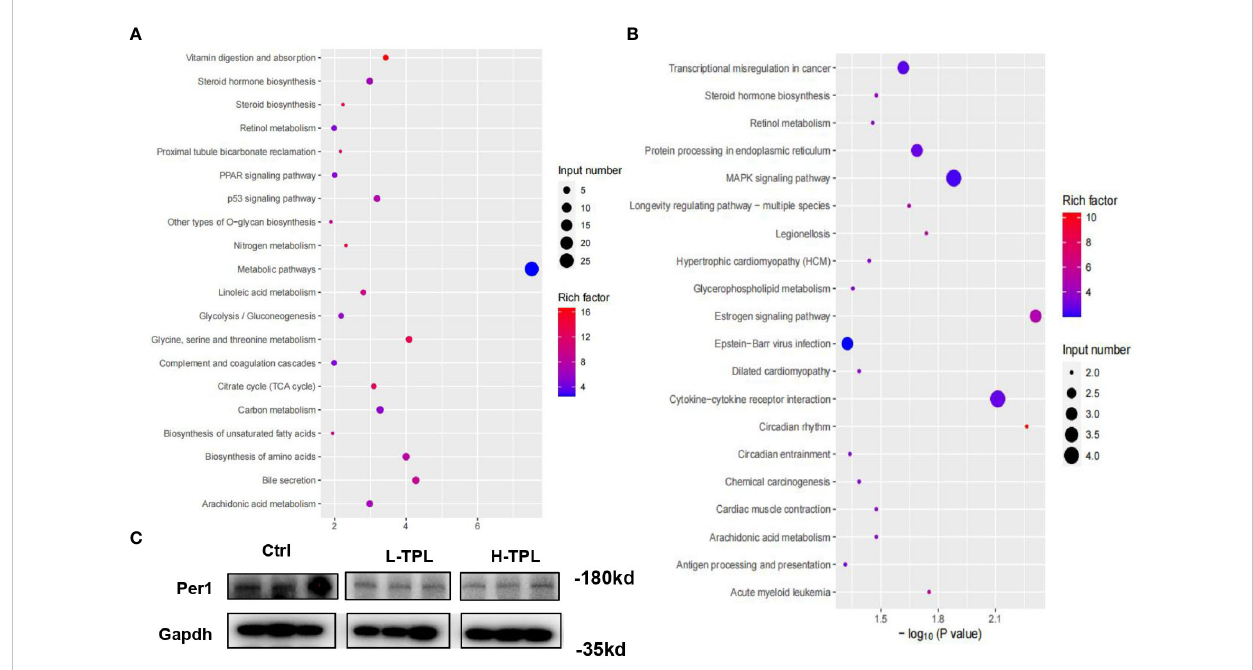
FIGURE 4 Identi fi cation of signi fi cant dysregulated genes in the renal tissues of H-TPL rats. (A, B) KEGG enrichment analysis of signi fi cant overexpressed (A) and downexpressed genes (B, C) Western-blot assay of Per1 in Ctrl, L-TPL and H-TPL